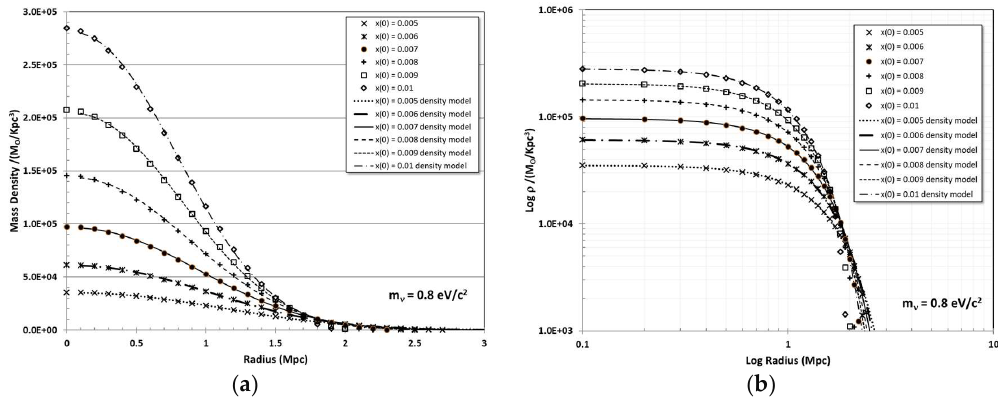
Figure 3. The figure shows the mass density (ρ) per solar mass per Kilo-parsec (kpc) cubed against the CNO radius in Mega-parsecs (Mpc) for a degenerate neutrino mass of 0.8 eV/c 2 for central x(0) boundary conditions ranging from 0.005 to 0.01 with overlaid Einasto density model fits as: ( a ) linear-linear plot; ( b ) log-log plot. ( a ) linear-linear plot; ( b ) log-log